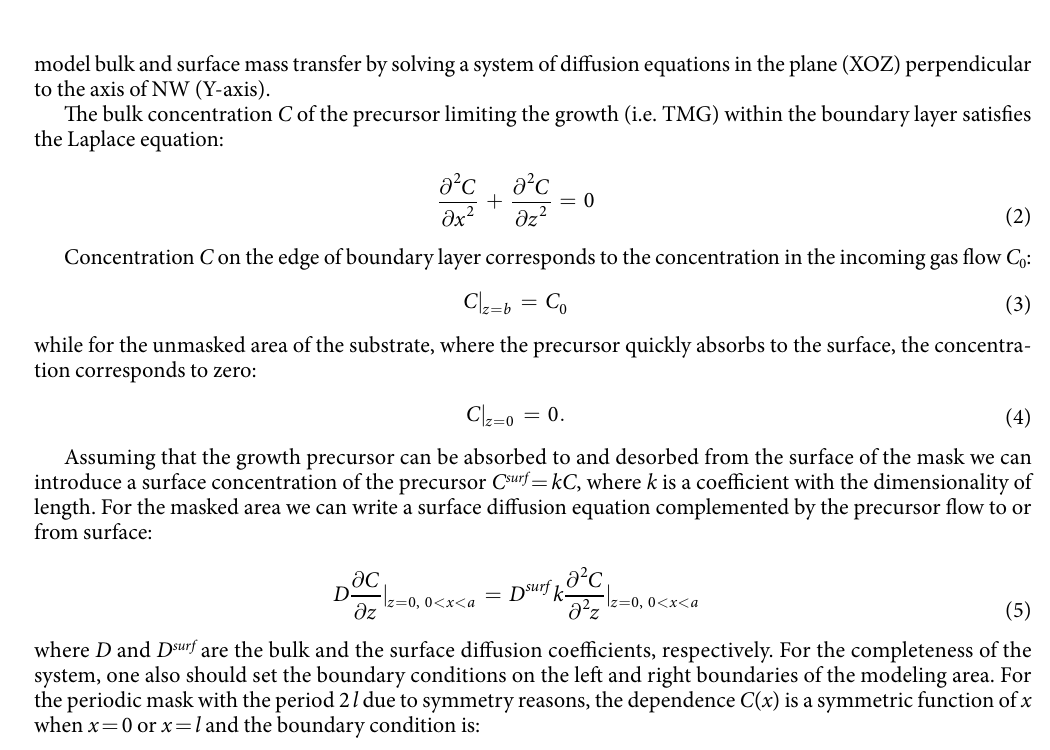
Figure 2. Modelling of the diffusion of growth precursors in the boundary layer under the masked surface. The half of the period of the structure, widths of the mask, open area and thickness of the boundary layer are denoted as l, a, w and b , respectively. ( a ) Concentration of the growth precursor C in the boundary layer over the masked surface calculated using differential equation (Eq. 2) and boundary conditions Eq. (3–8). Solid circular lines shows an isoline of bulk concentration used for development of a simplified analytical model. The dashed circular line indicates the distance corresponding to the mean free path of the precursors in gas (all shown not to scale). ( b ) Dependence of the relative growth rate R on the filling factor F calculated by Eq. (9) (blue circles), by analytical estimate Eq. (11) (red line) and dependence 1/ F (green line). The squares show the experimentally obtained values of R . Upper top scale shows the corresponding width of the open area w . A horizontal dashed line shows the saturation value of the relative growth rate R S , while a vertical dashed line shows the size of the open area corresponding to the mean free path of the precursor in the